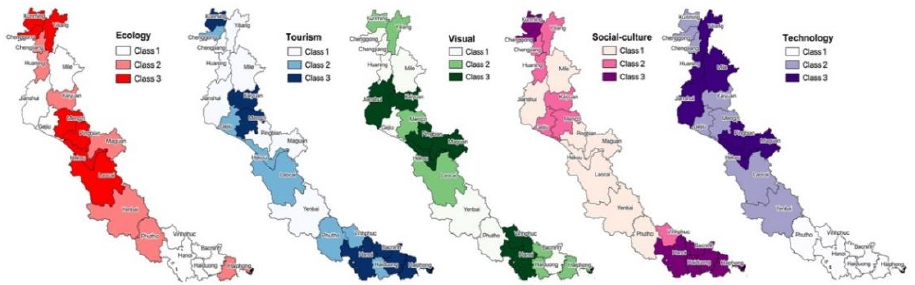
Figure 5. Visualization of each topic of indicators. The classification of each class: class 1 means low value, covering 0–1.6; class 2 means middle value of 1.7–3.3; and class 3 means high value of 3.4–5.